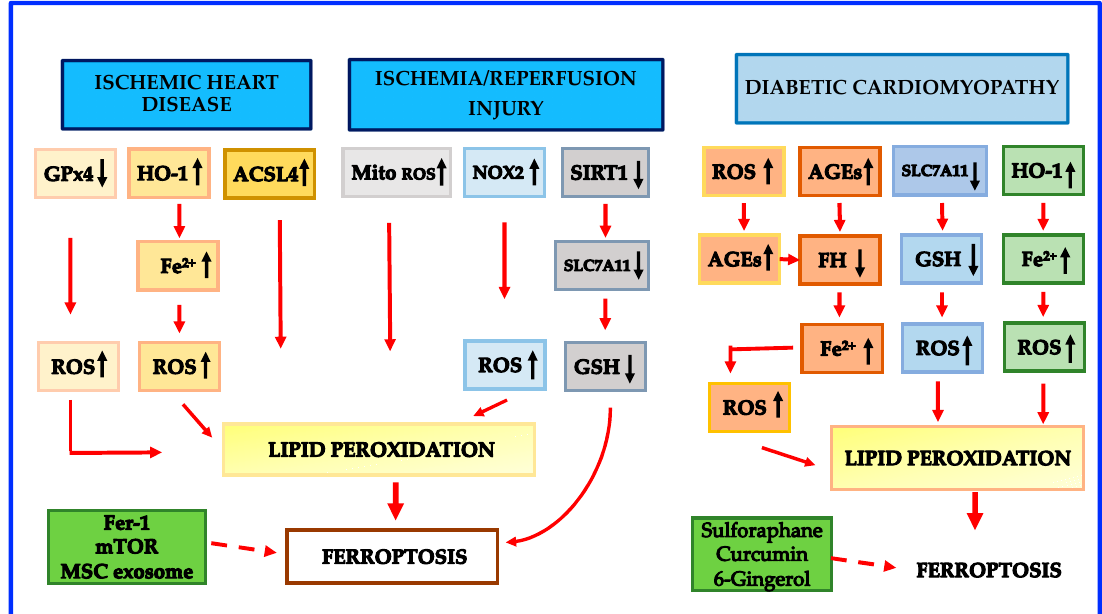
Figure 2. Schematic mechanisms leading to ferroptosis in Ischemic Heart Disease, Ischemia Reperfusion/Injury and Diabetic Cardiomyopathy. Abbreviations: ACSL4: Acyl-Coenzyme A synthetase long-chain family member 4; AGEs: advanced glycation end-products; FER-1: ferrostatin 1; GPX4: glutathione peroxidase 4; GSH: reduced glutathione; HO-1: heme oxygenase-1; MITO ROS: mitochondrial ROS; MSC: mesenchymal stem cell; mTOR: mechanistic target of rapamycin; NCOA4: nuclear receptor coactivator 4; NOX: nicotinamide adenine dinucleotide phosphate oxidase; ROS: reactive oxygen species; SIRT1: sirtuin 1; SLC7A11: solute carrier family 7A member 11 subunit. Legend: dotted arrows = inhibition of ferroptosis .